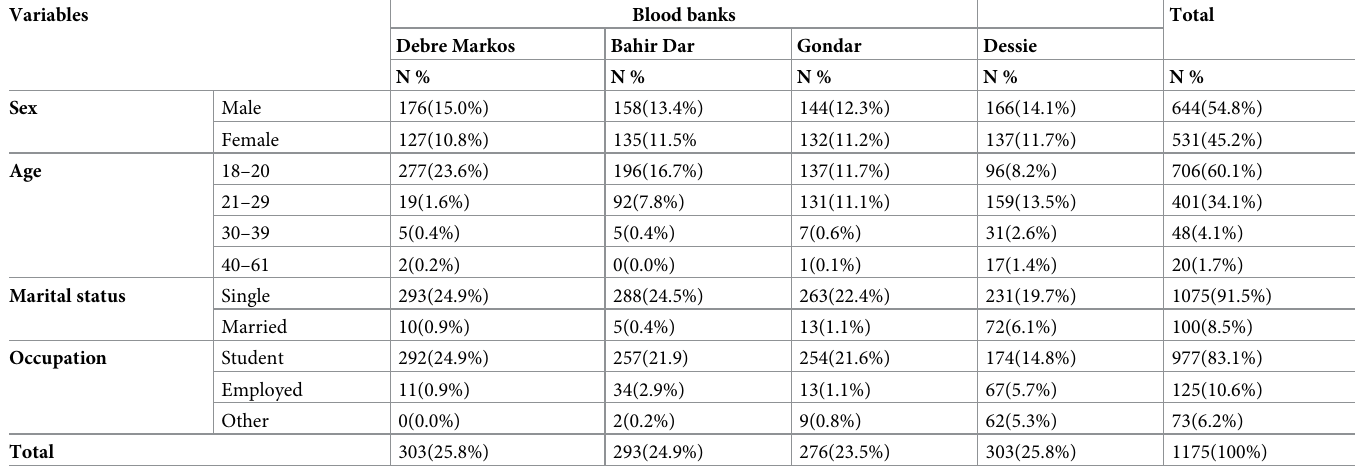
Variables Blood